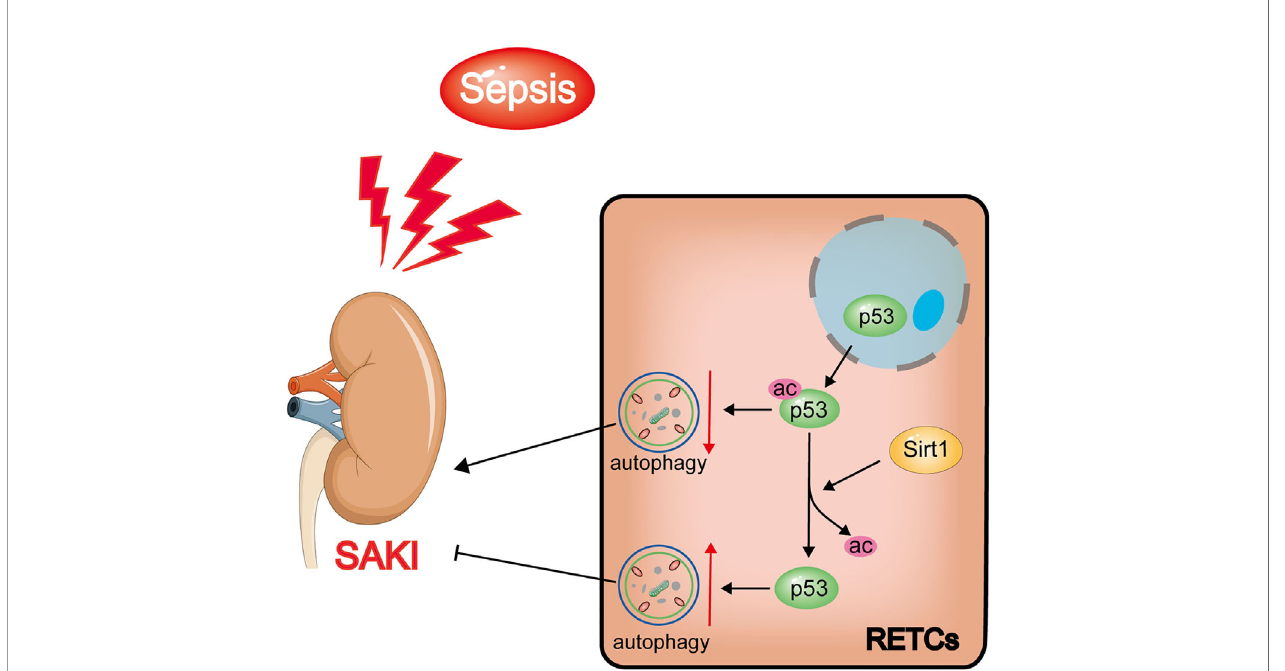
FIGURE 11 | Schematic diagram showing the effects of Sirt1-induced p53 deacetylation on autophagy activation in septic-associated acute kidney injury (SAKI). The p53 total protein expression does not change signi fi cantly, but the nuclear to cytoplasmic translocation and acetylation increased in renal tubular epithelial cells (RTECs) following sepsis. The elevated acetylation of p53 promotes autophagy inhibition and aggravates SAKI. The deacetylation of p53 induced by Sirt1 can attenuate this process to a certain